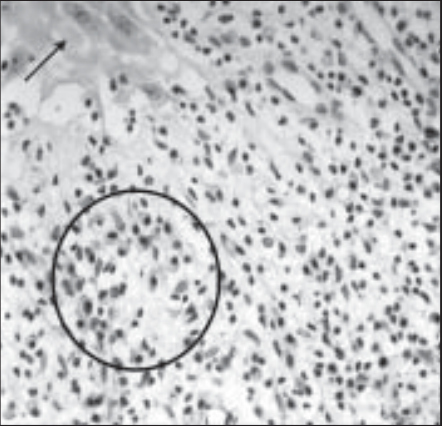
Figura 10 – Líquen plano oral. Vacuolização da camada basal, corpos de Civatte (seta), linfócitos e plasmócitos (círculo) (HE, aumento original 400x)